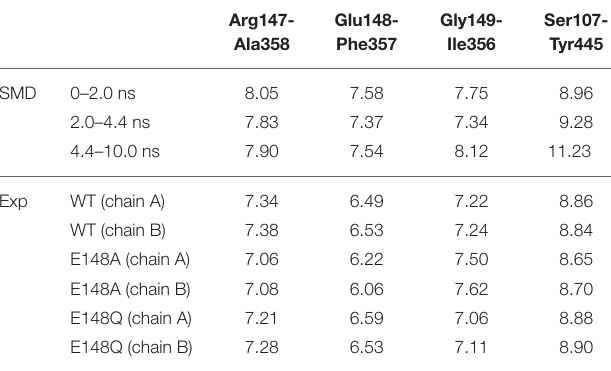
TABLE 1 | Average distances (in Å) between pairs of C α atoms for selected residues: Arg147-Ala358, Glu148-Phe357, Gly149-Ile356, and